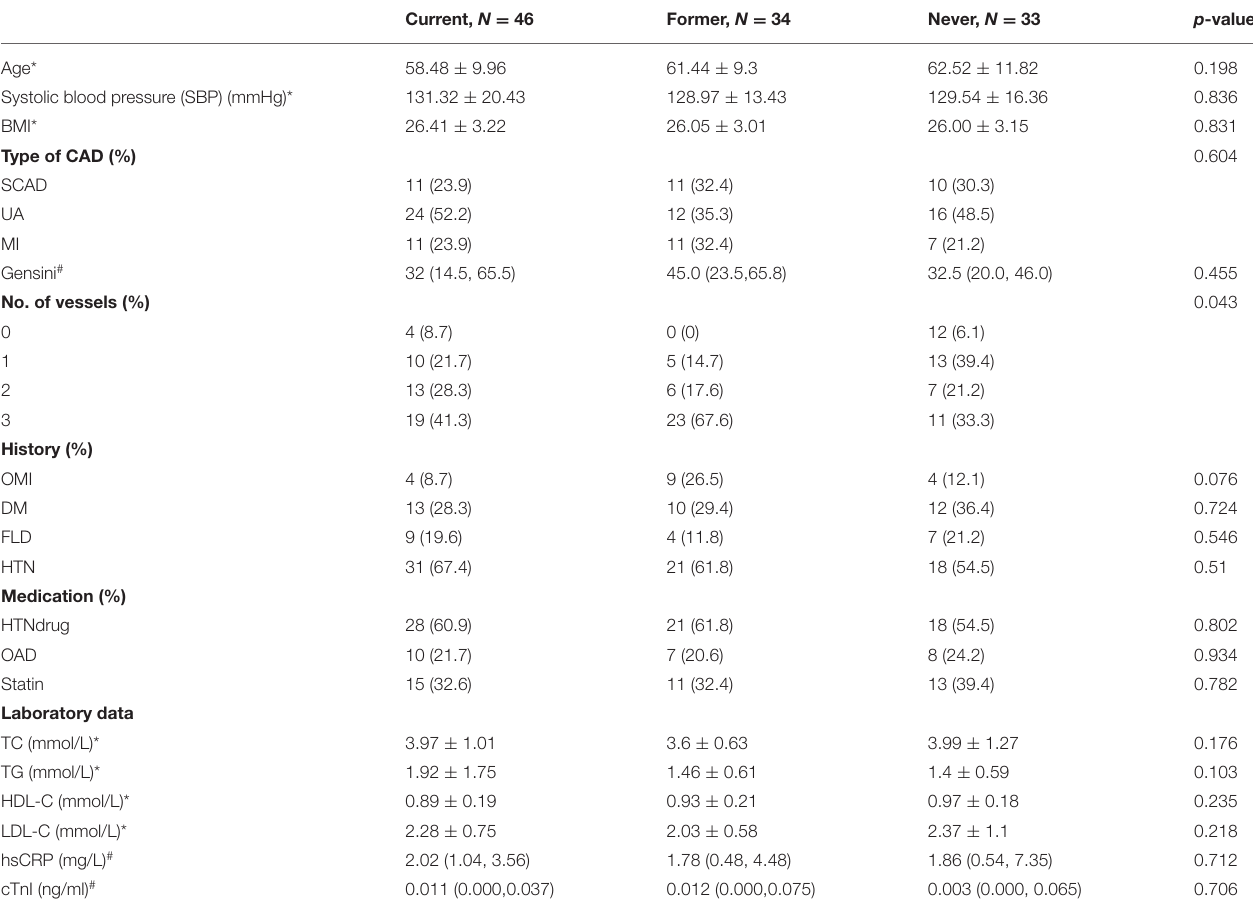
TABLE 1 | Characteristics of the study cohort.